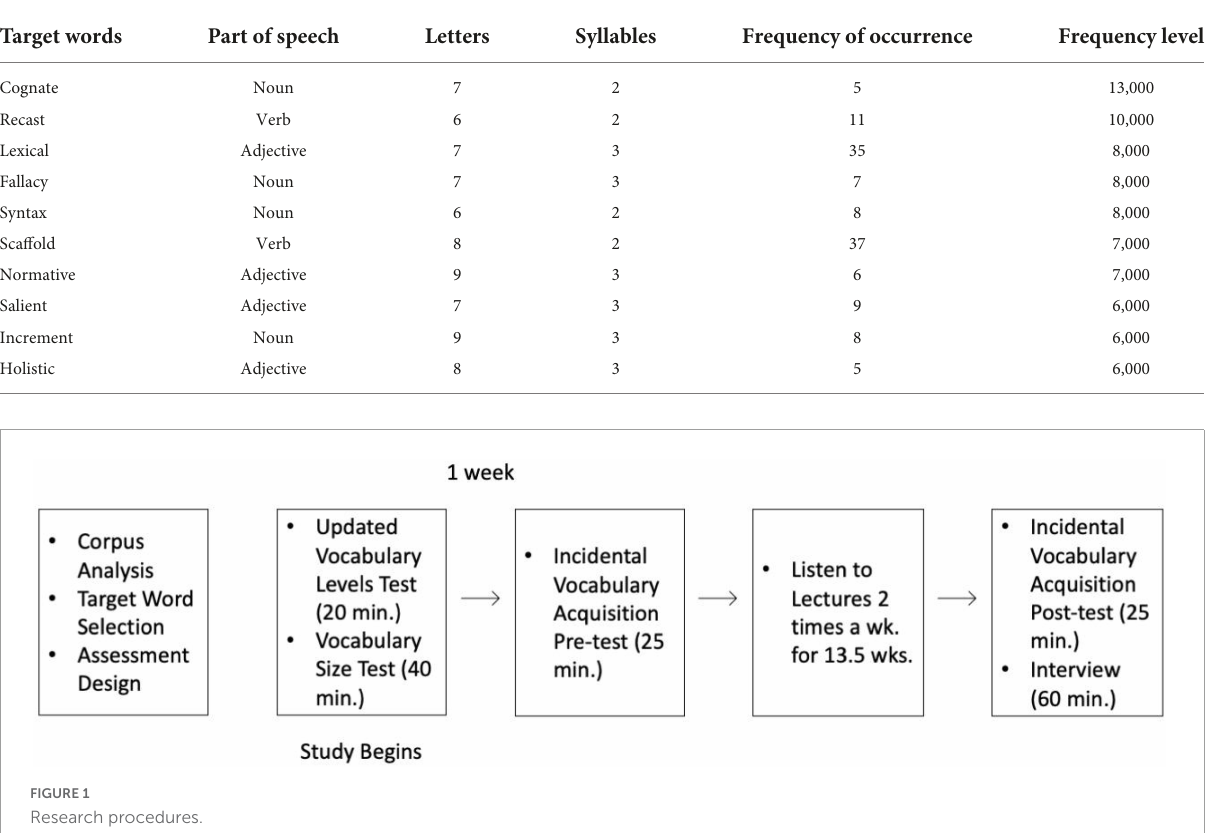
TABLE 1 Profile of the target words.